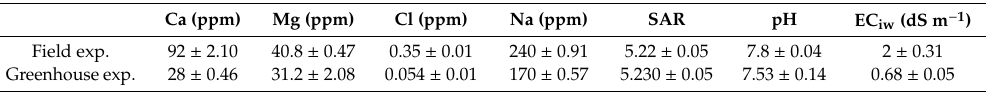
Table 2. Chemical properties of the irrigation water used for the control treatments in field and greenhouse experiments. Ca (ppm) Mg (ppm) Cl (ppm) Na (ppm) SAR pH EC iw (dS m − 1 ) Field exp. 92 ± 2.10 40.8 ± 0.47